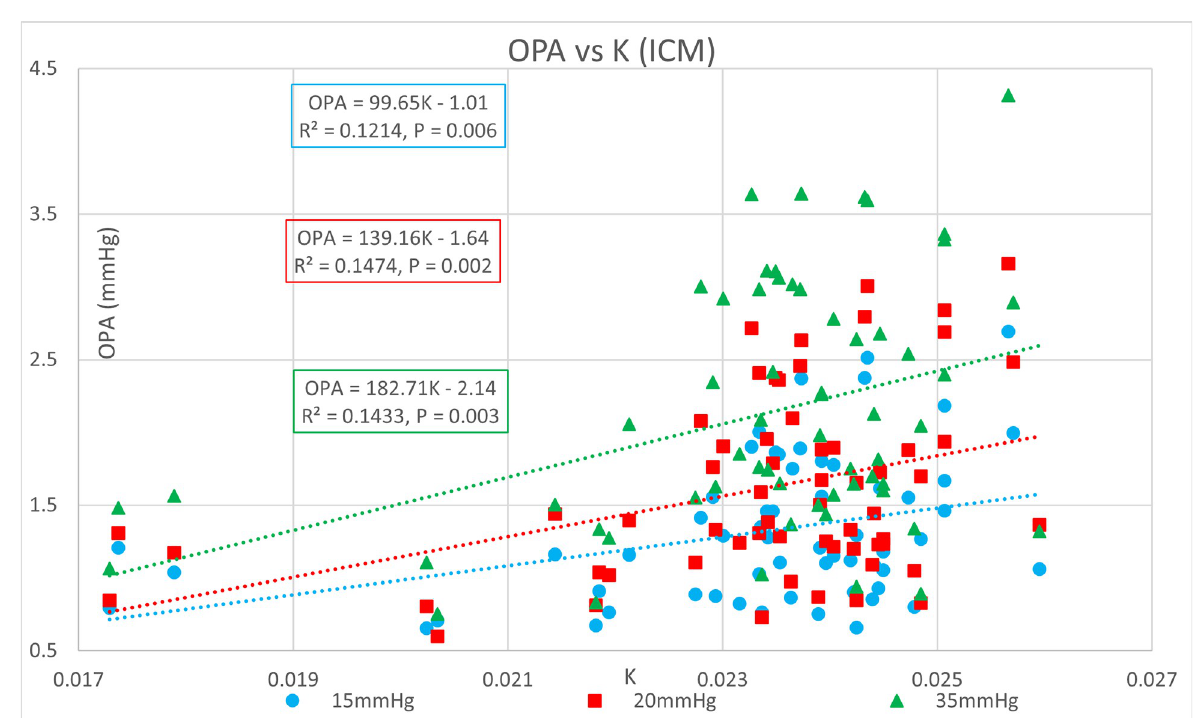
Fig 2. Positive correlation of OPA to estimated OR (K) for ICM measurements.